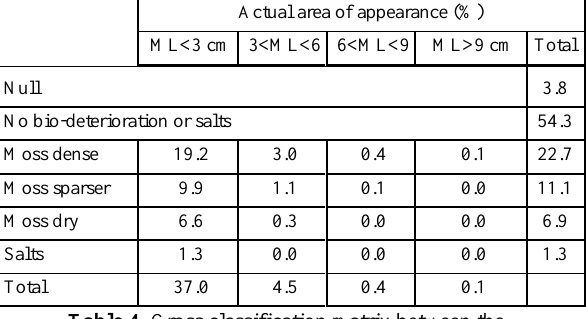
Table 4. Cross classification matrix between the